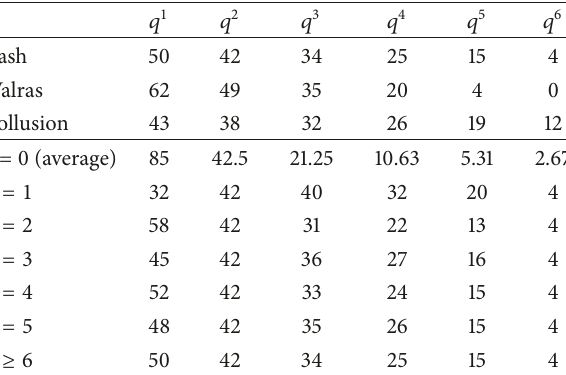
Table 2: The first three rows present the Nash, Walras, and collusive quantities for each period as in Table 1. The fourth row gives the average production quantity for the alternative definition of level- 0 foreachperiod.Theremainingrowsgivethetrajectoriesfordifferent level- 𝑘